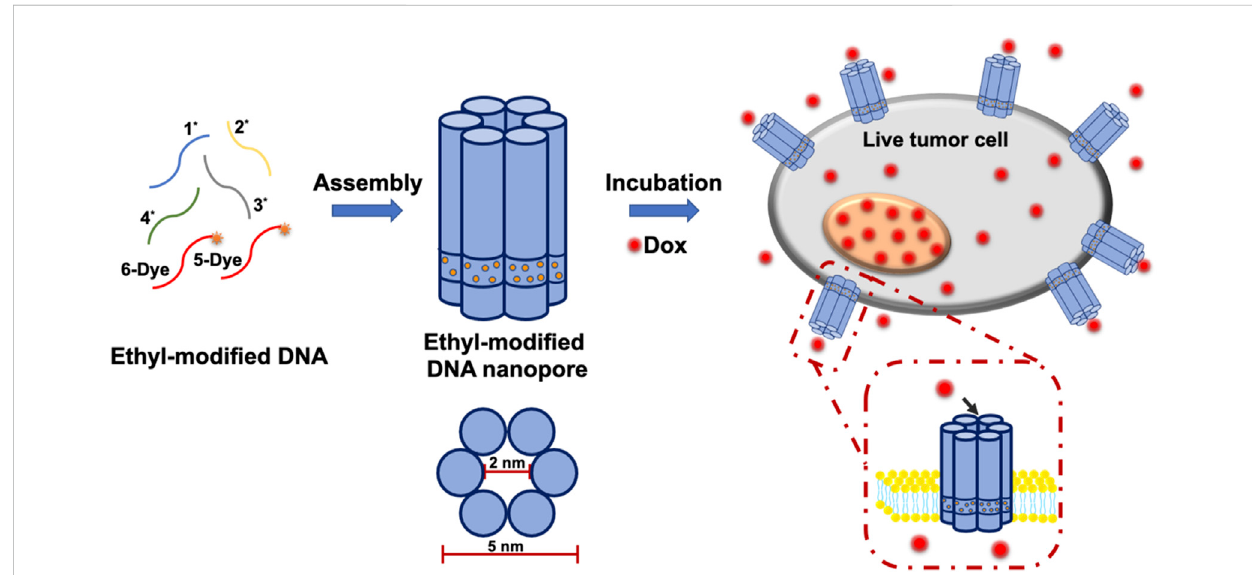
FIGURE 1 Illustration of the construction of E-DNA nanopores and the insertion of E-DNA nanopores in the plasma membrane of live cells.